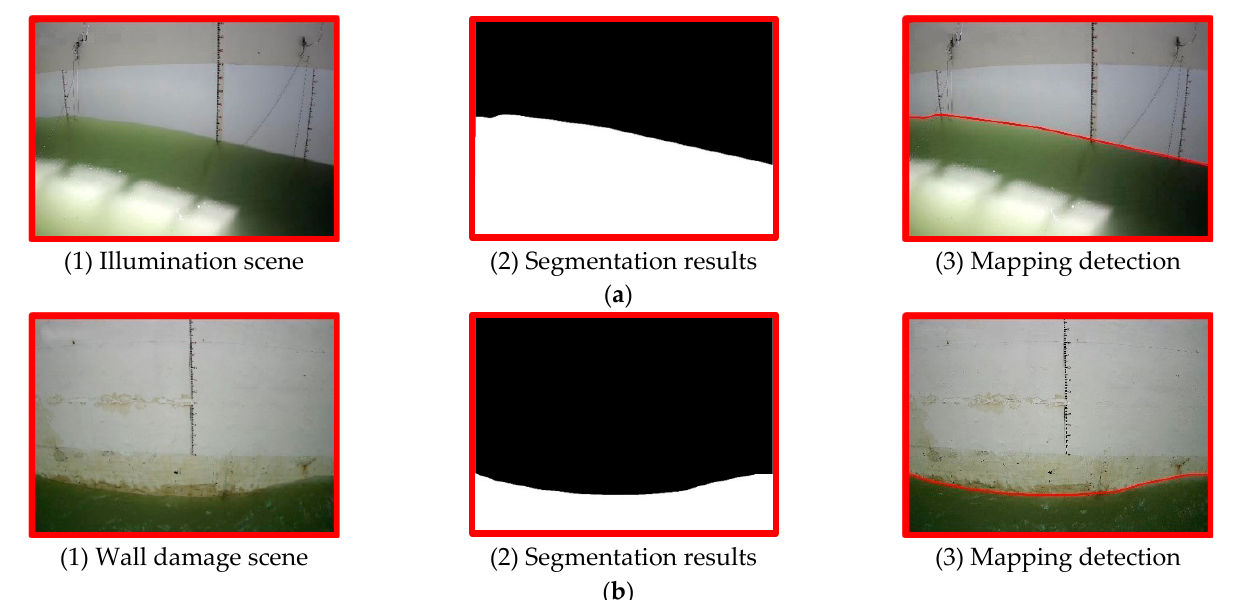
Figure 6. Segmentation results and mapping detection: ( a ) Segmentation results and mapping detection of illumination scene; ( b ) Segmentation results and mapping detection of the wall damage scene.